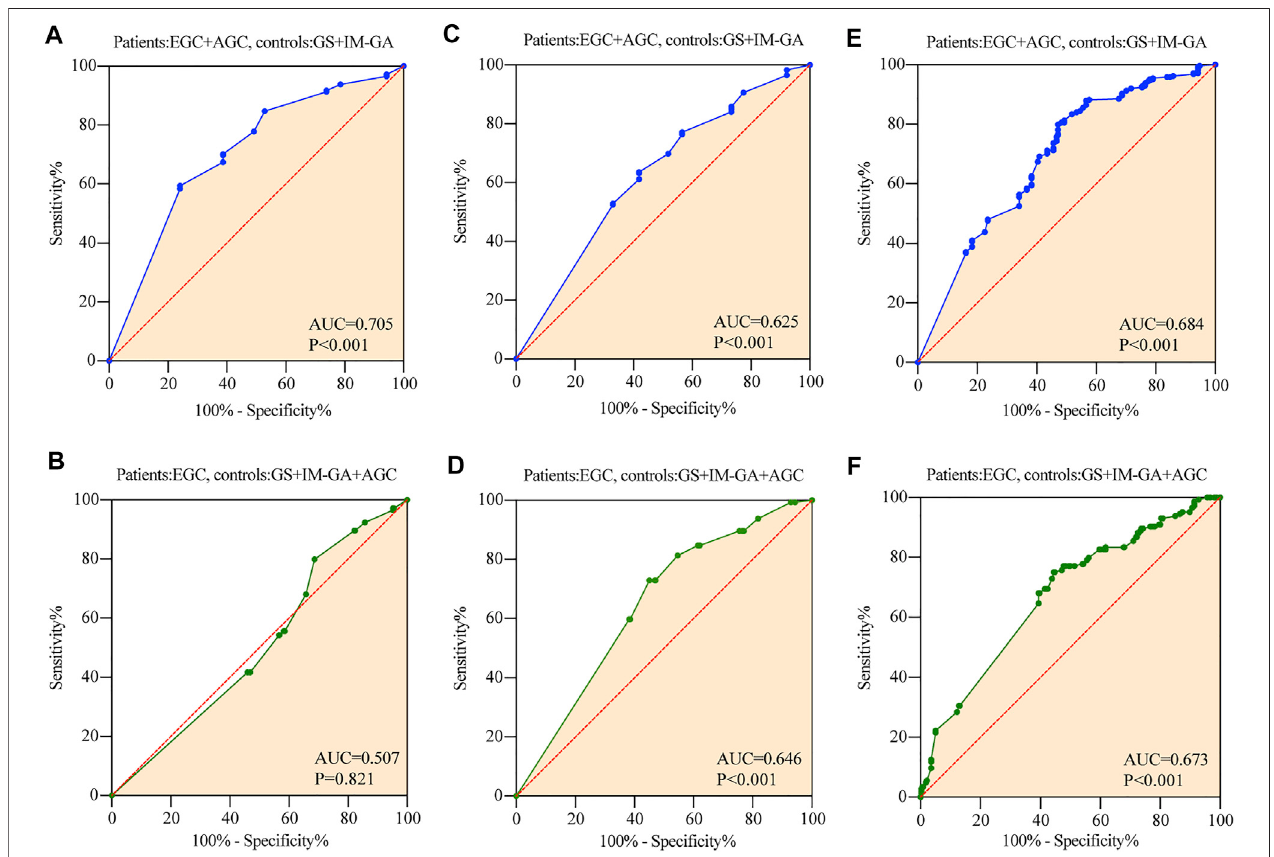
FIGURE 3 | The diagnostic value of TRIB3 and FABP1 for GC. TRIB3 had signi fi cant diagnostic value for GC (A) , but had no diagnostic value for EGC (B) . FABP1 had signi fi cant diagnostic value for both GC (C) and EGC (D) . Combined TRIB3 with FABP1 had signi fi cant diagnostic value for both GC (E) and EGC (F) .